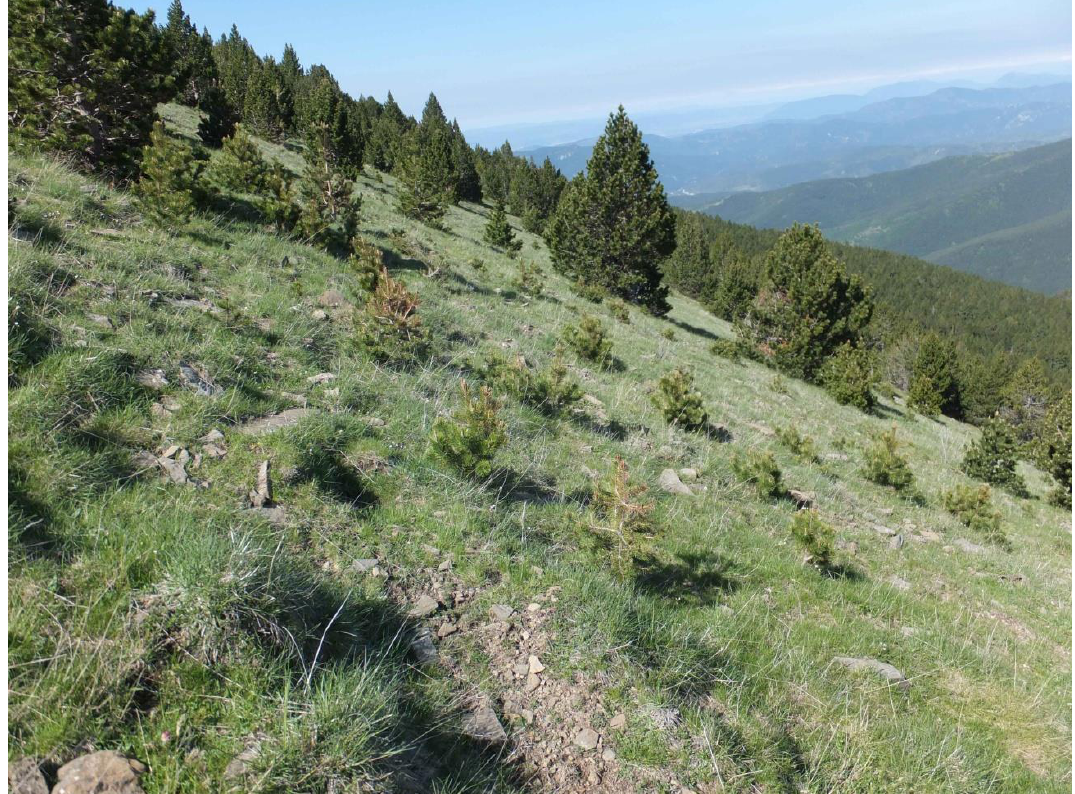
Figure 3. Recent colonization by P. Uncinata in the subalpine belt in the Spanish Pyrenees (Las Blancas), as a consequence of a decline in livestock grazing (particularly sheep). The taller trees are 20 years old and the small trees are 3–4 years old. Photo by José M. García-Ruiz.